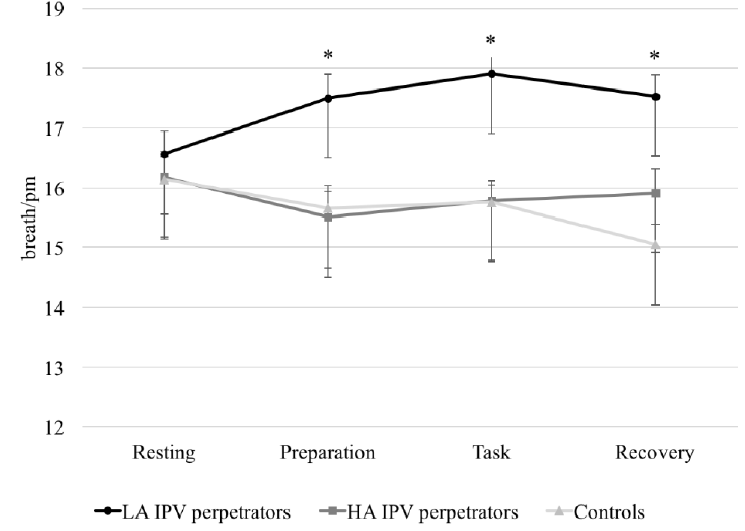
Figure 1. Respiratory rate (RR) (breath//pm) in response to acute stress (with different levels of alcohol consumption) and controls (* p < 0.05). LA: low alcohol; HA: high